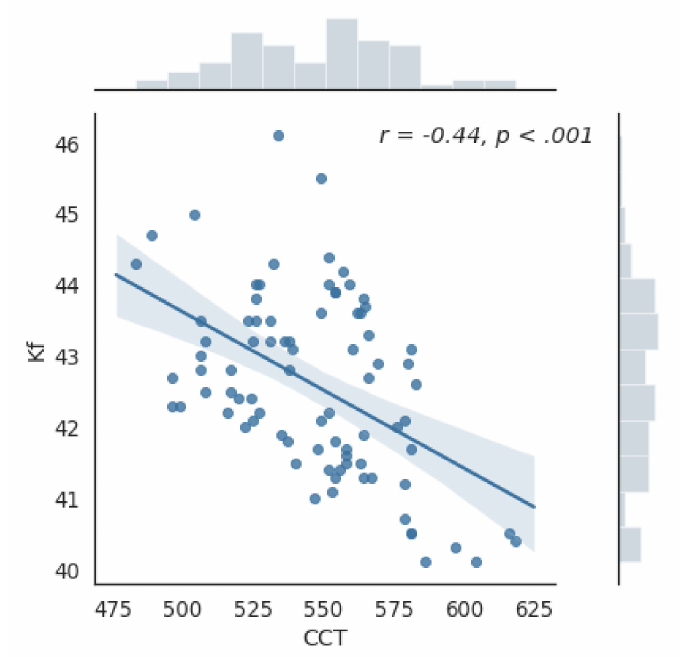
Figure 2. Graph of the correlation between the value of the plane meridian of anterior keratometry (Kf) and the thickness of the central cornea (CCT). Correlation coefficient r = − 0.44; p < 0.001.